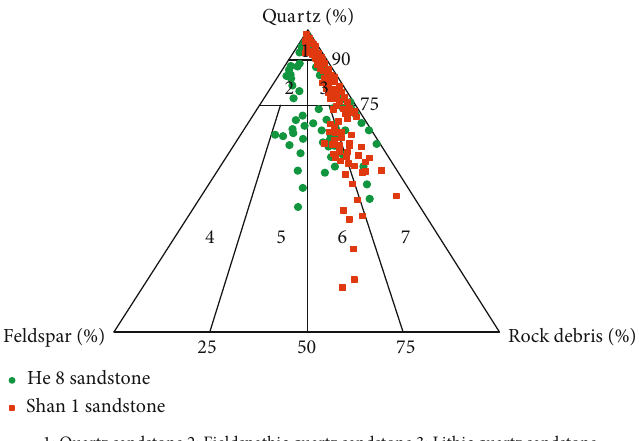
Figure 4: Lithologic triangle map of Upper Paleozoic in the study area.